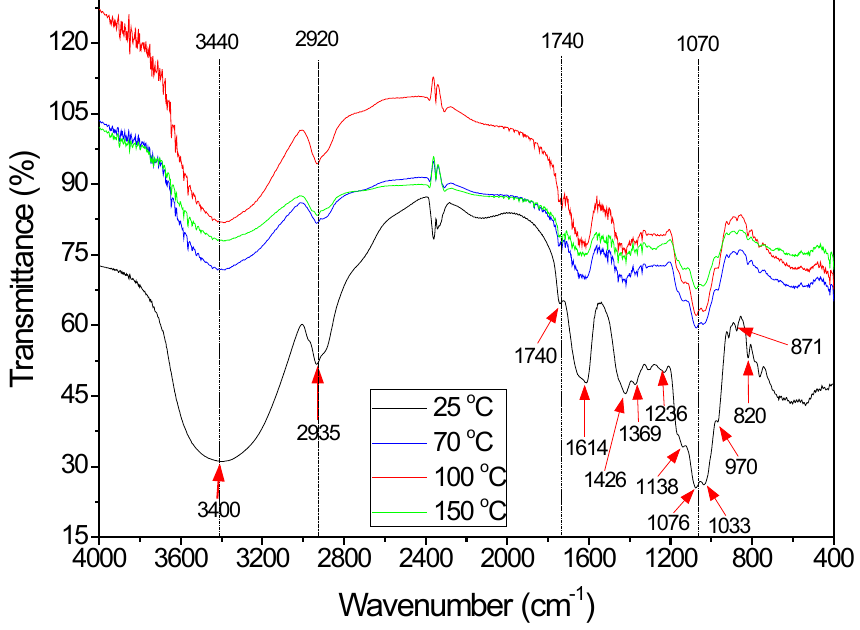
Figure 1. Spectra in the infrared region for BG.